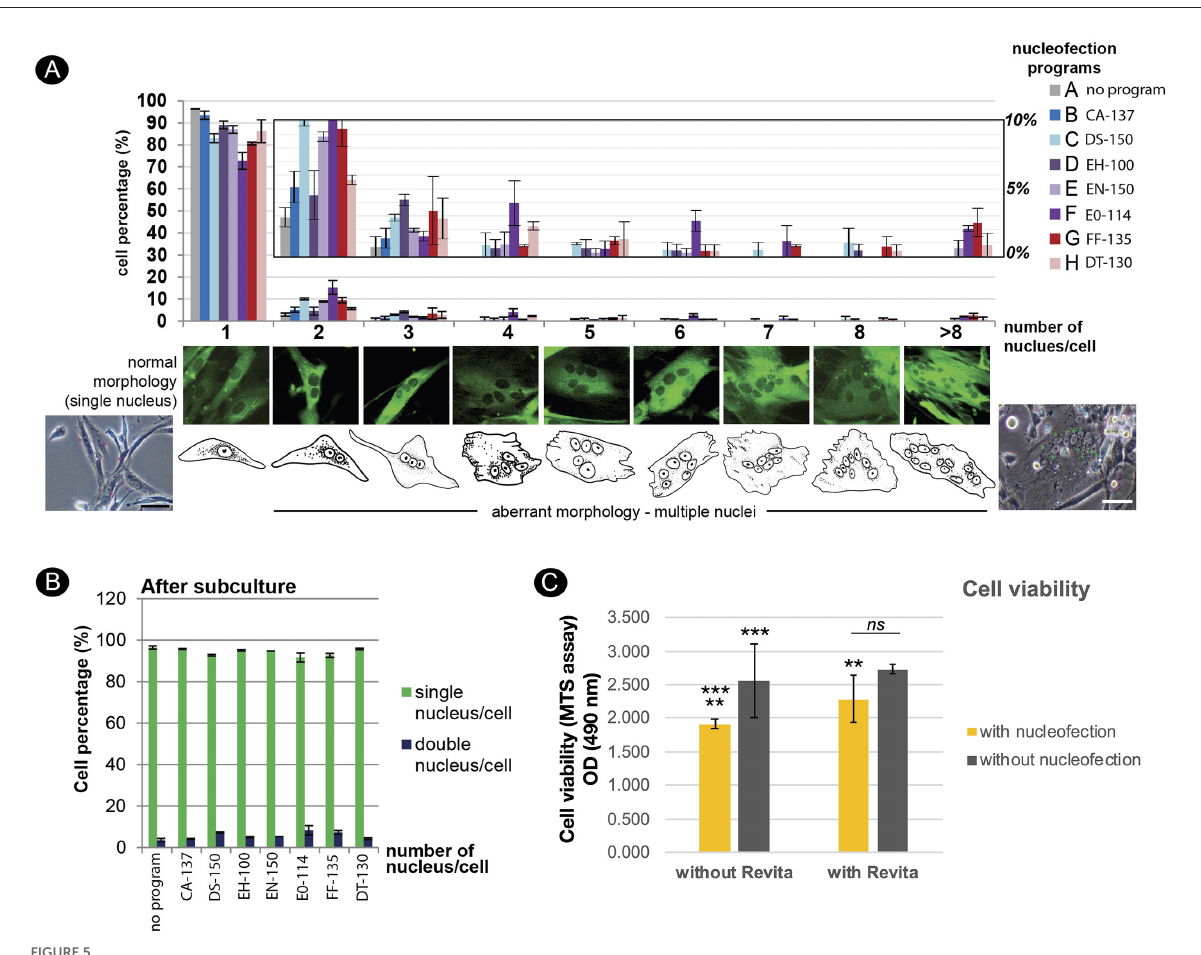
FIGURE5 Effects of nucleofection on multinucleation and cell viability of adult dermal fibroblast derived from fishing cat. (A) Multinucleation occurred in different levels from various Nucleofector TM programs. Top panel shows a graph depicting the incidence of multinucleation from different Nucleofector TM programs. The Y-axis value represents the percent of transfected cells with one or more nuclei per cell (mean ± standard deviation). The X-axis indicates the number of nuclei per cell. The middle panel shows the morphology of GFP expressing cells with different types of multinucleation. The bottom panel shows brightfield images and cartoons of fibroblast cells with a single nucleus and multiple nuclei. (B) The graph indicates the number of nuclei per cell as in (A) from subculture of the transfected cells at day 3 post-passaging or day 7 post-transfection. Subculture of transfected cells removed multinucleation from all examined programs. (C) Graph shows cell viability of fibroblast cells after nucleofection with program FF-135 with or without RevitaCell TM supplement. Cell viability was evaluated by MTS assay and quantified with spectrophotometer at 490nm as shown in Y-axis. Mean indicates the average of absorbance values from four independent experiments with three technical replicates each. Error bar indicates standard deviation. Asterisks (** and ***) indicate significant difference ( p < 0.05 and p < 0.01, respectively, Student’s t -test), and “ns” indicates not significant ( p <